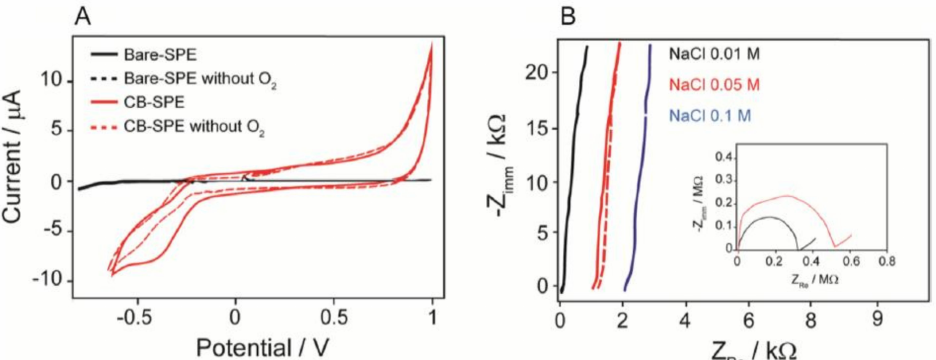
Figure 36. ( A ) Cyclic voltammetry was performed using 100 µ L of 100 mM NaCl in the absence (dashed line) and presence (solid line) of oxygen, using Bare-SPE (black) and CB-modified SPE, with a scan rate of 25 mV/s. ( B ) Different NaCl concentrations were used to achieve electrochemical impedance spectroscopy using and CB-SPE. (Reproduced from [578] with permission. Copyright 2021, Elsevier, Amsterdam, The